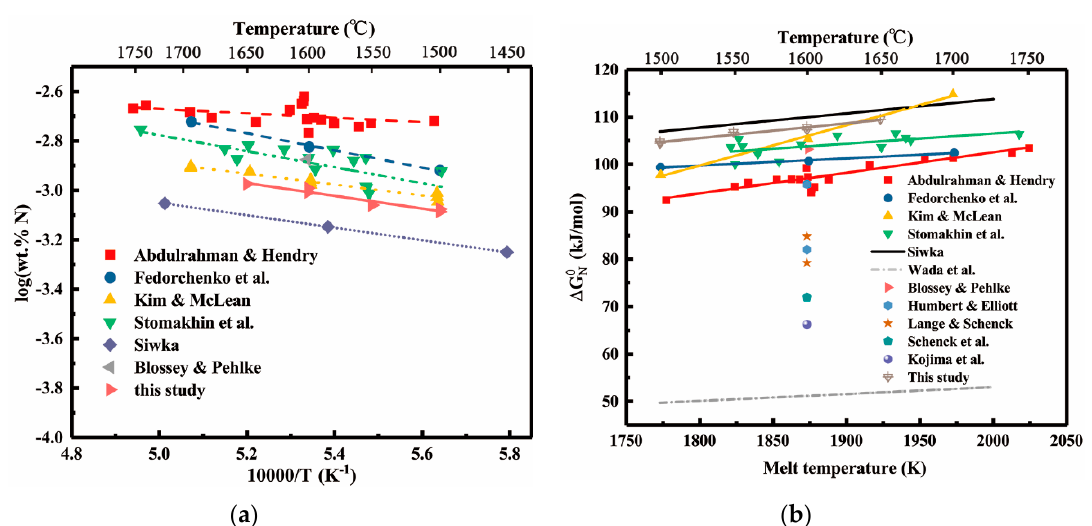
Figure 3. ( a ) Van’t Hoff relationship for the nitrogen solubility in liquid pure nickel; ( b ) Gibbs free energy of the nitrogen dissolution reaction in liquid pure nickel.